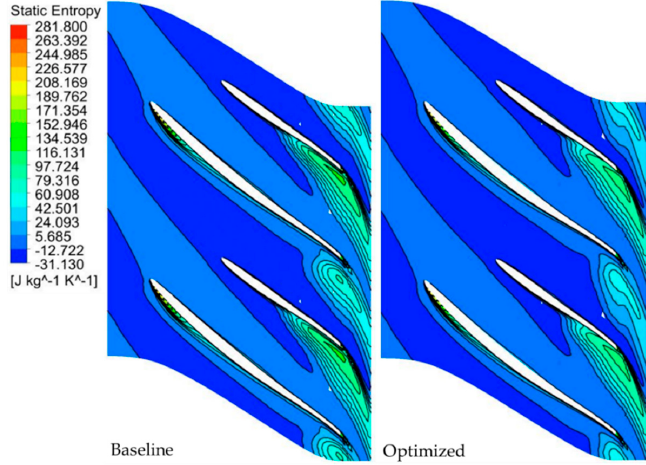
Figure 19. Static entropy distribution for span 0.5 at the blade-to-blade contour.